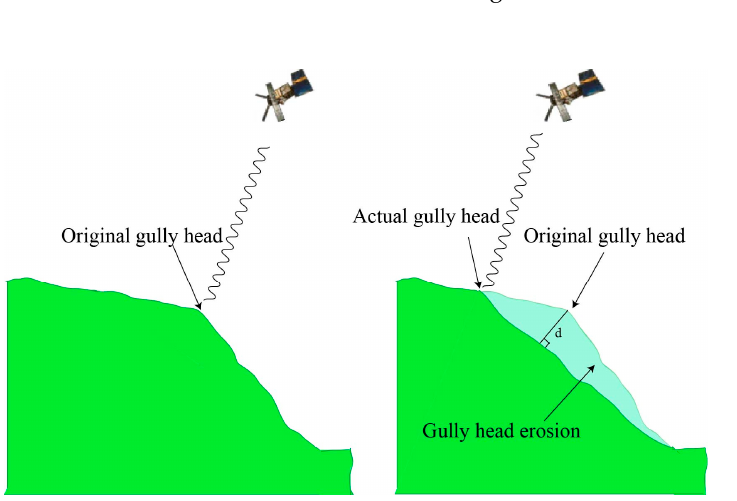
Figure 9. Gully head erosion measured with small-baseline-subset-interferometry synthetic aperture radar (SBAS-InSAR).